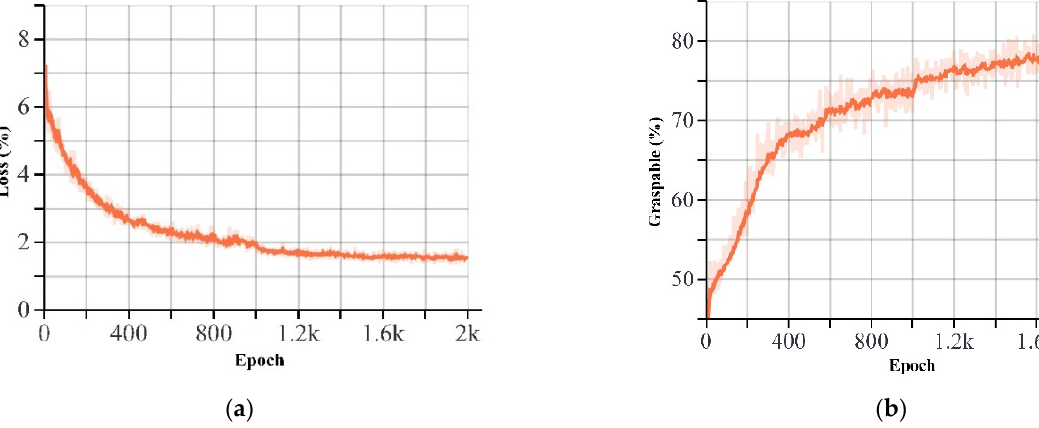
Figure 7. Training evaluation results: ( a ) loss curve; ( b ) graspable curve.